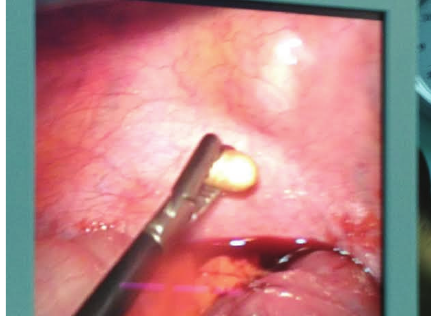
Figure 4: Laparoscopic view of the grasping of the bullet in the Douglas